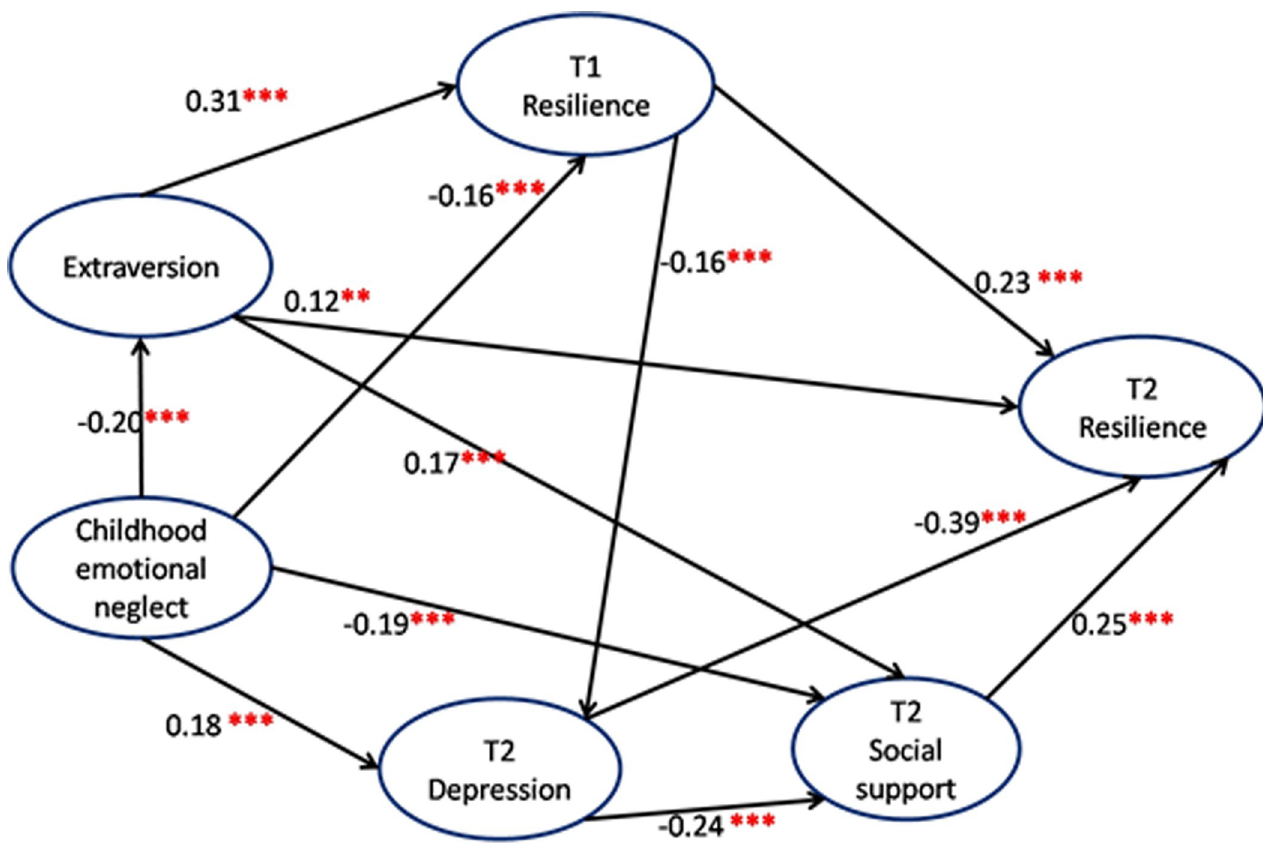
Fig 2. Structural equation model for T2 resilience. Note: ��� P < 0.001. �� P < 0.01. T1 = Year 2016. T2 = Year 2018. Key information of model: CFI = 0.995, IFI = 0.996, NFI = 0.989, RFI = 0.944, RMSEA = 0.039, CMIN/DF = 1.65.